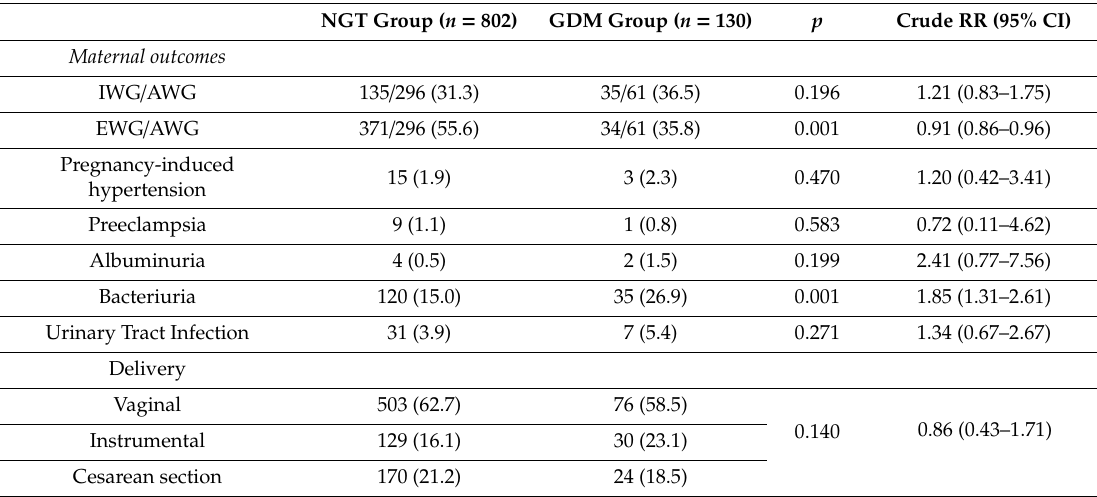
Table 3. Maternal and neonatal adverse